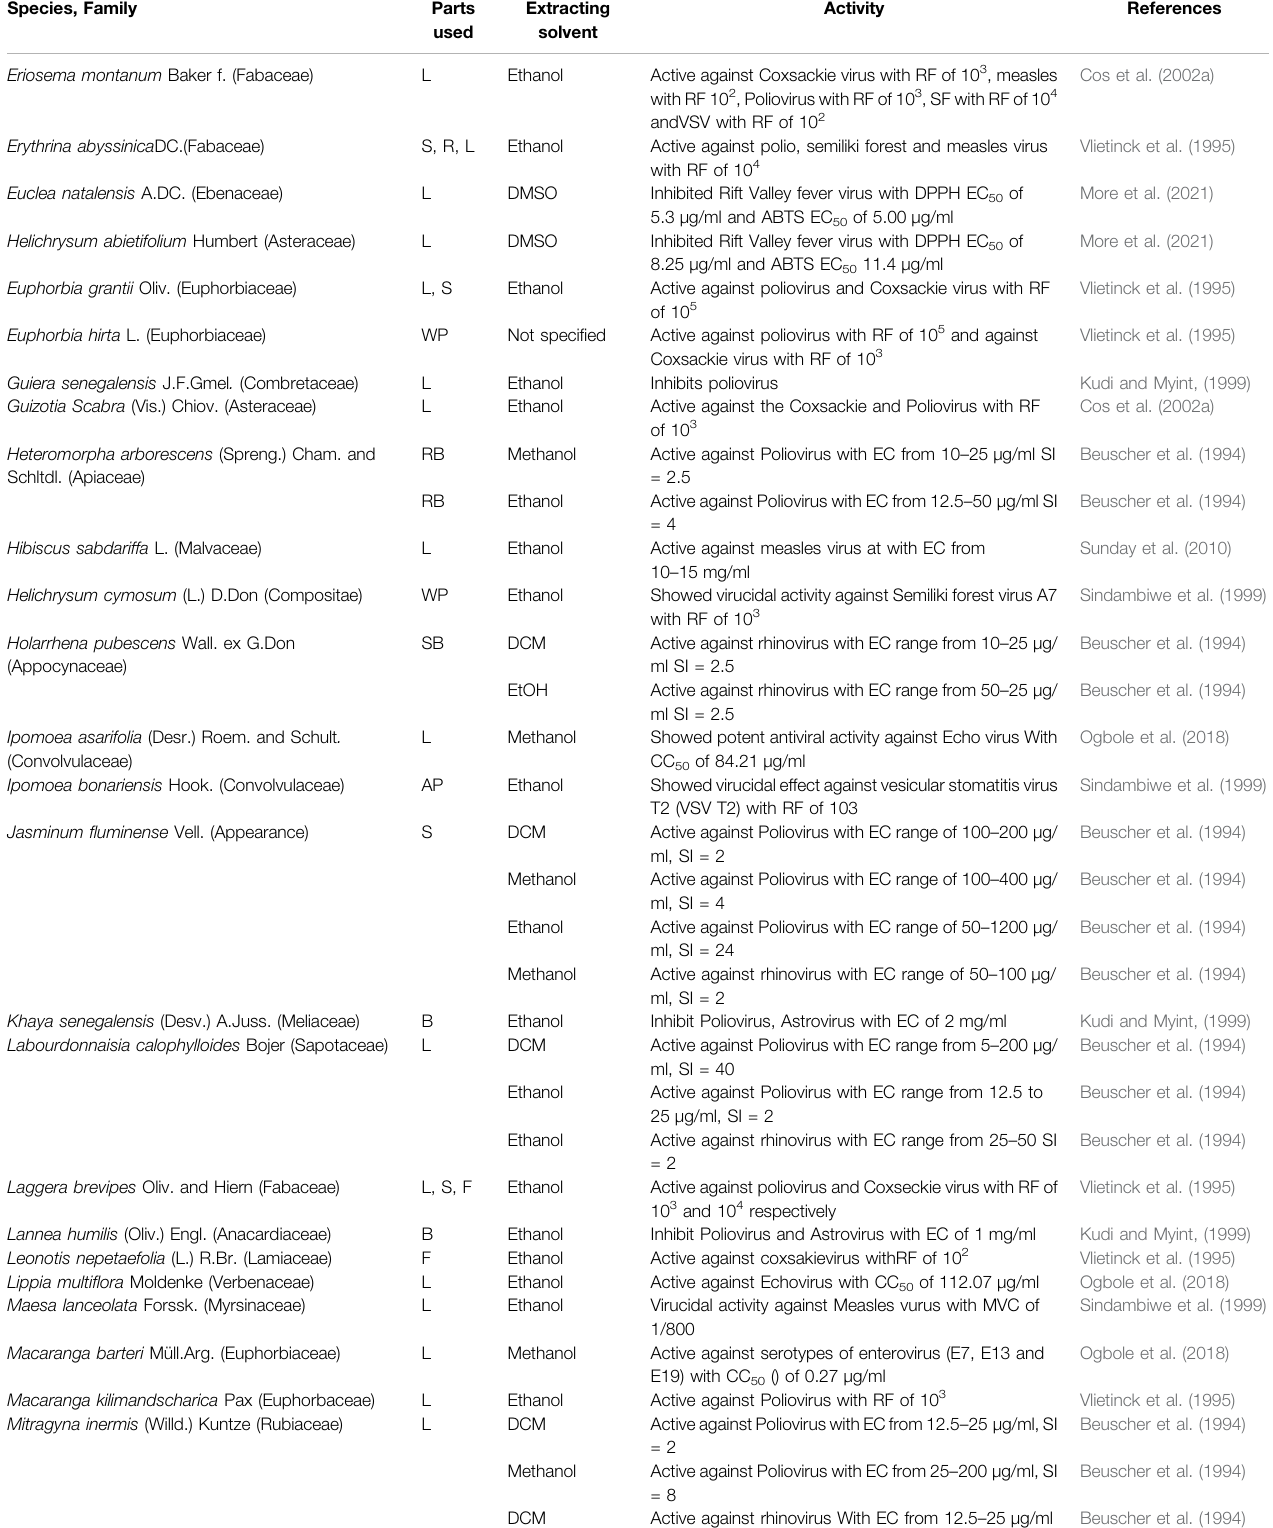
TABLE 4 | ( Continued ) Antiviral activity of African medicinal plants against poliovirus, astrovirus, coxsackievirus, Rift Valley fever virus, zika virus, measle, echovirus, yellow fi ver virus, parvovirus, chikungunya virus, cytomegalovirus,